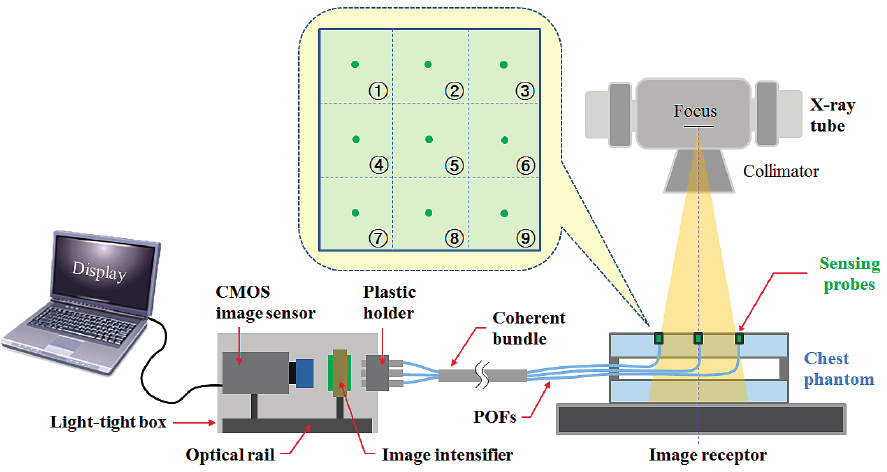
Figure 2. Experimental setup using a multichannel all-in-one phantom dosimeter and a DR system. The real-time scintillation images (RSIs) including the intensified nine scintillation signals are taken by a CMOS image sensor (acA3800-14uc, BASLER, Ahrensburg, Germany) with a single lens optical system. The RSIs are converted into red-green-blue (RGB) image files by the MATLAB program (MATLAB ® , MathWorks, Natick, MA, USA) and subsequently transformed to gray scale. The gray-scale image format is corrected by multiplying the calibration factor acquired from a reference parameter. chest phantom, the RSIs were measured to obtain the planar dose distribution, which changed with the